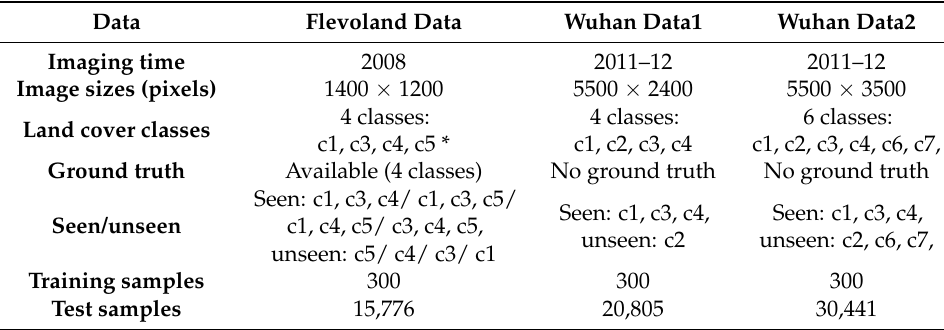
Table 3. The data description of the employed PolSAR